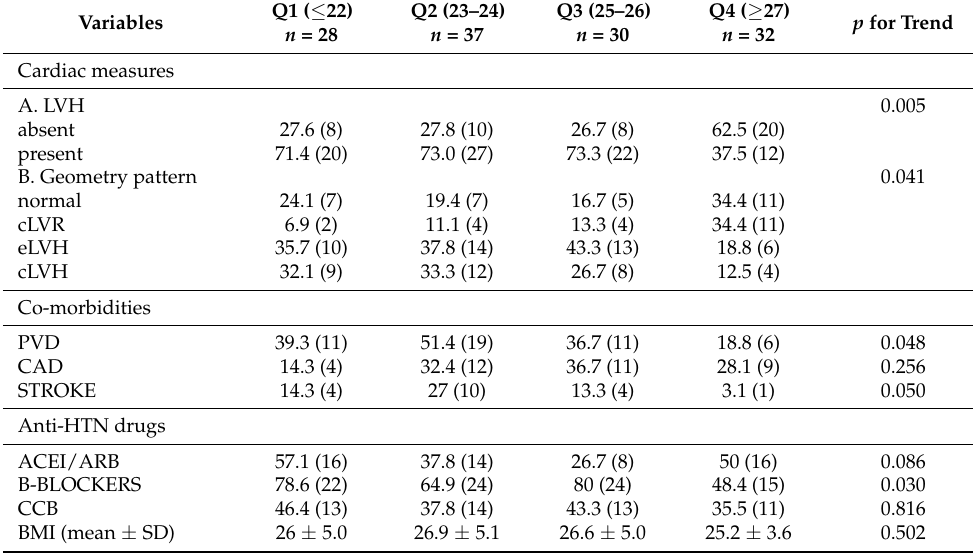
Table 6. Cardiac measurements, co-morbidities, antihypertensive drugs, and BMI according to the quartiles of MDS.